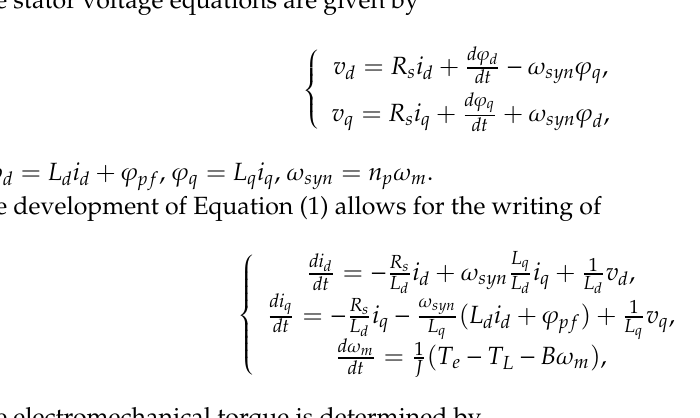
Figure 2. Two-phase representation of PMSM.